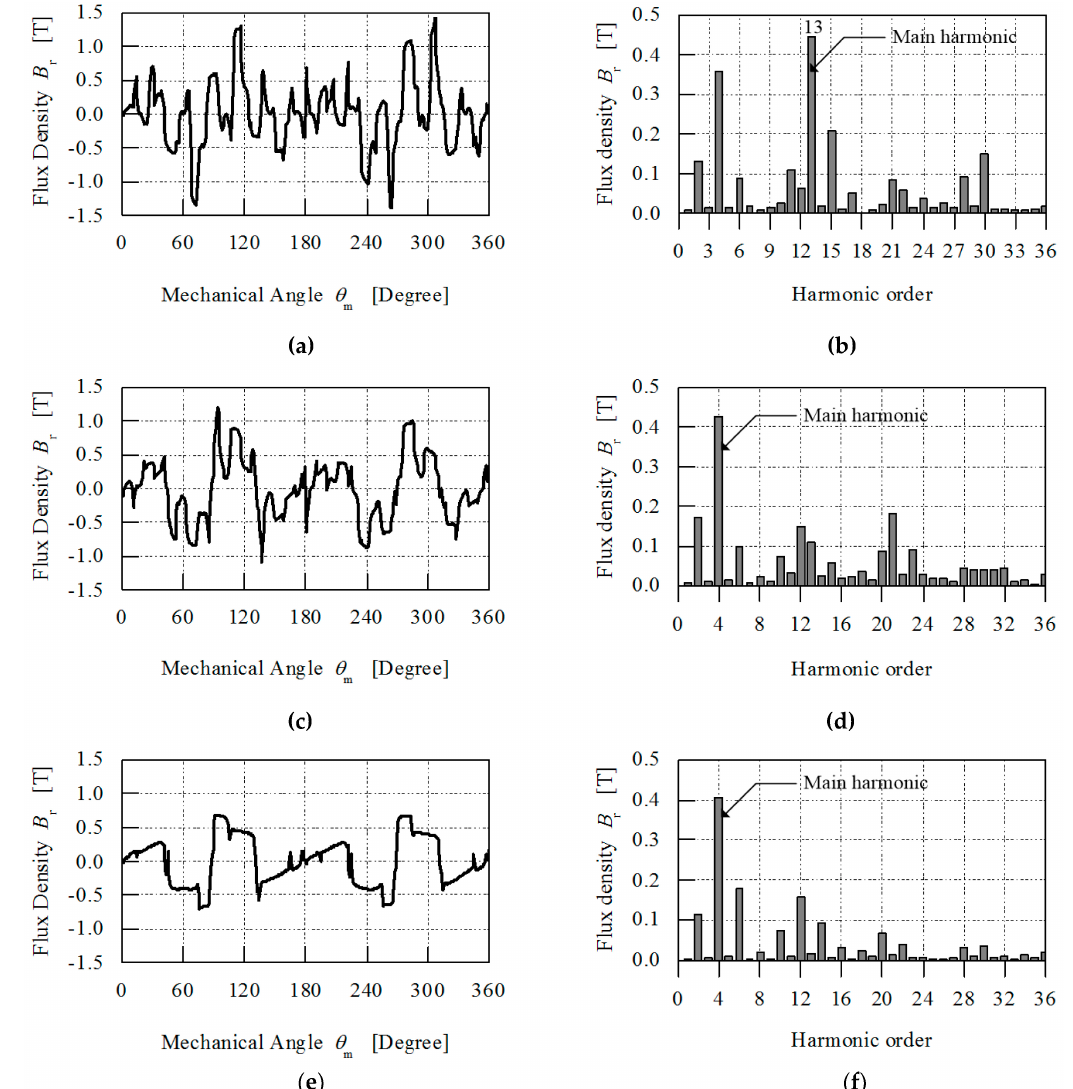
Figure 12. The outer magnetic gear flux density characteristics: ( a ) Flux density between outer pole-pole ring and prime PM; ( b ) Fast Fourier Transform of ( a ); ( c ) Flux density between outer PM and outer pole-pole ring; ( d ) Fast Fourier Transform of ( c ); ( e ) Flux density between outer PM and outer stator; ( f ) Fast Fourier Transform of ( e ).